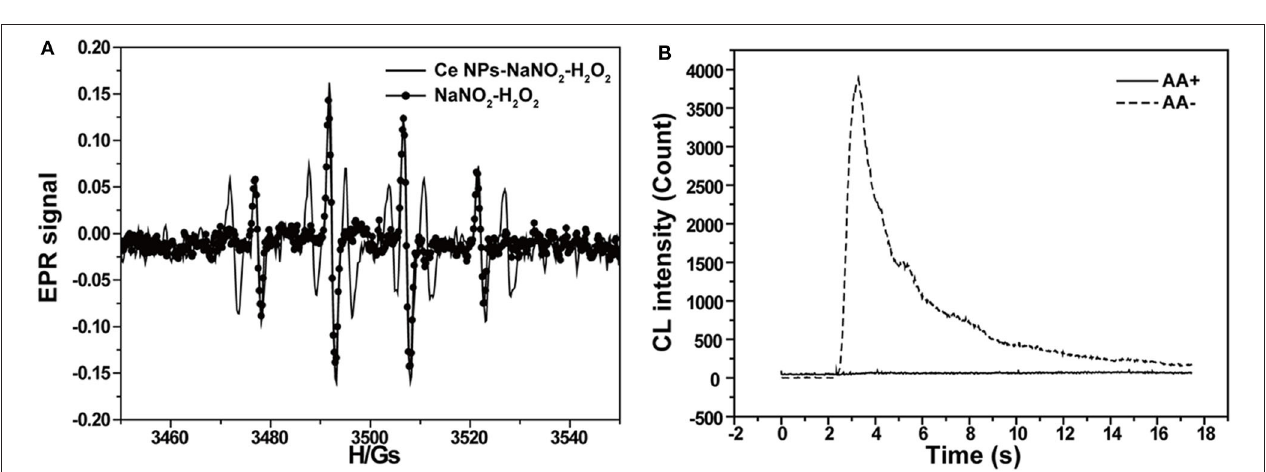
FIGURE 4 | CL mechanism study of the LaF 3 :Ce NPs-NaNO 2 -H 2 O 2 system. (A) EPR spectra of · OH generated via the reaction of DMPO probe in the LaF 3 :Ce NPs-NaNO 2 -H 2 O 2 and NaNO 2 -H 2 O 2 systems. (B) CL profiles of the LaF 3 :Ce NPs-NaNO 2 -H 2 O 2 system with and without AA. Conditions: 3.00M H 2 O 2 in 0.04M H 2 SO 4 , 50 µ l of LaF 3 :Ce NPs, 10 µ M NaNO 2 solution, 12.4 µ l of DMPO in 1ml of H 2 O, and 0.1mM AA. Voltage of the PMT was set at 1.2